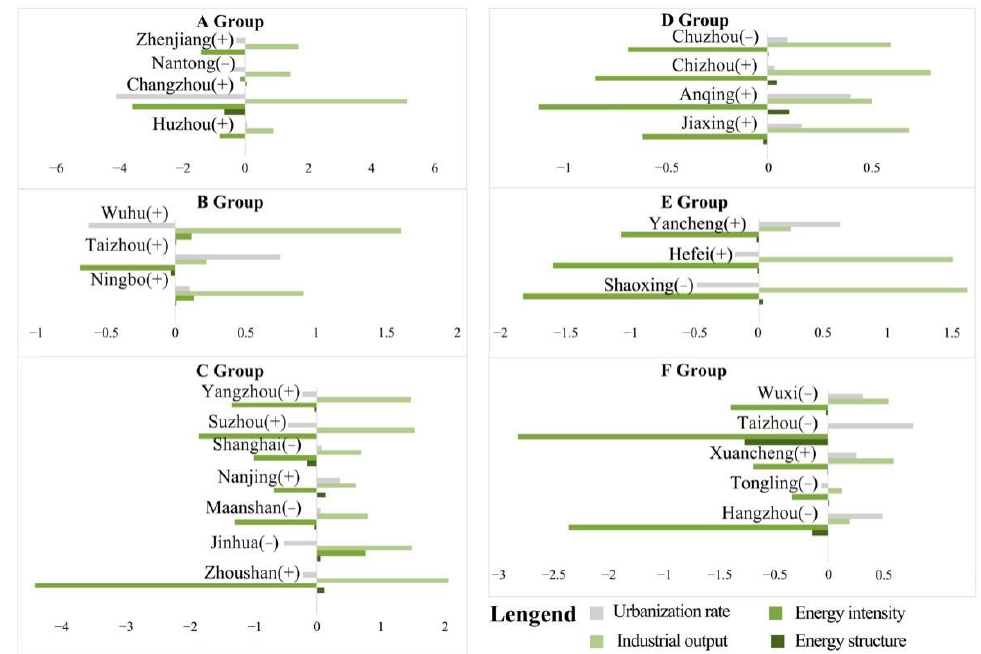
Figure 13. Cluster analysis results in the fourth period (2015 – 2020).